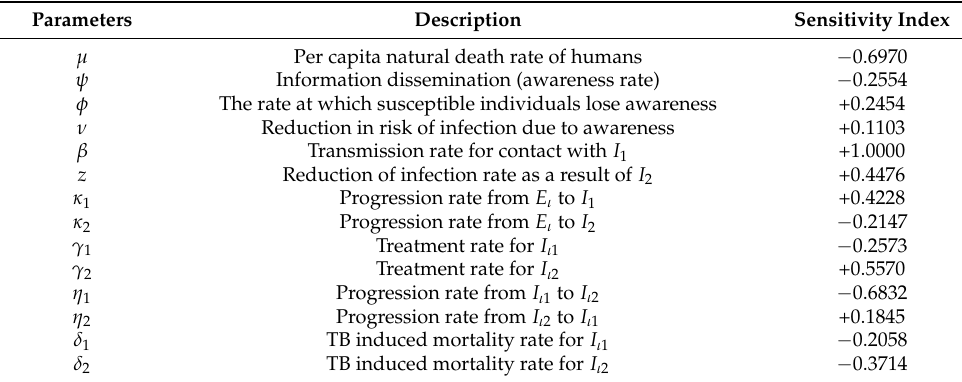
Table 2. Sensitivity Indices of the Model Parameters in Relation to R ph .